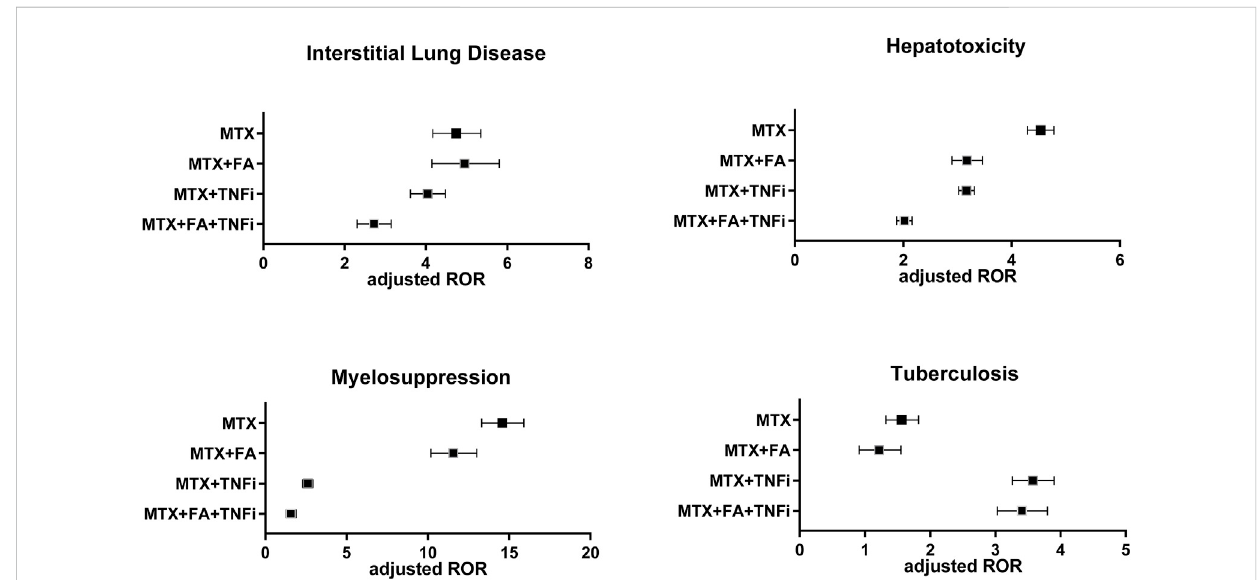
FIGURE 3 Adjusted reporting odds ratios (aRORs) (95% CI) for MTX-related adverse events (interstitial lung disease, hepatotoxicity, myelosuppression, and tuberculosis) calculated using the logistic regression analysis for each treatment pattern containing MTX (MTX, MTX + FA, MTX + TNFi, or MTX + FA + TNFi). CI, con fi dence interval; MTX, methotrexate; RORs, reporting odds ratios; FA, folic acid; TNFi, tumor necrosis factor